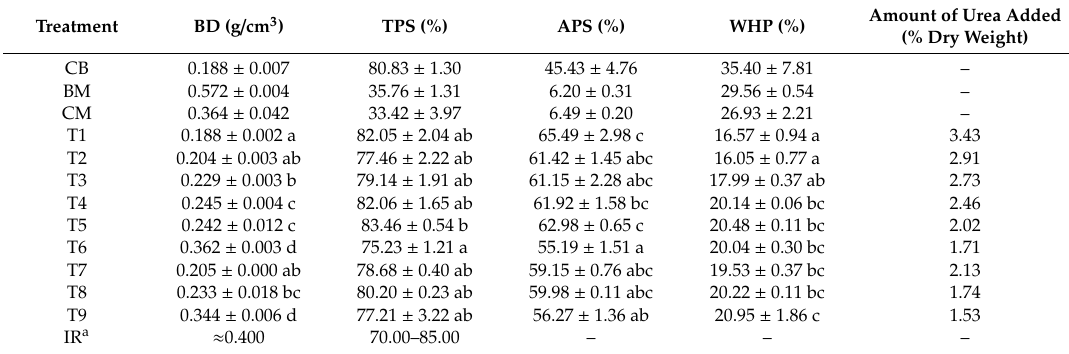
Table 3. Bulk density (BD), total porosity (TPS), aeration porosity (APS), water-holding porosity (WHP), and the amount of urea added to the nine separate or various mixtures of chestnut burrs (CB), cow manure (CM), bovine bone meal (BM), and of the final compost mixtures. Treatment BD (g / cm 3 )